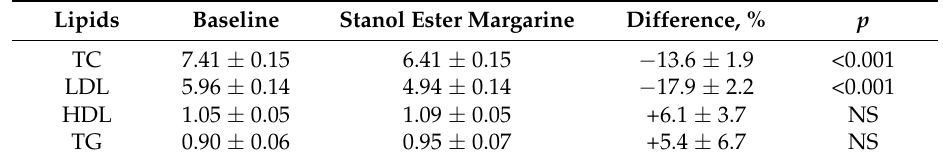
Table 1. Effect of dietary stanol ester margarine on serum lipids among 24 heterozygous familial